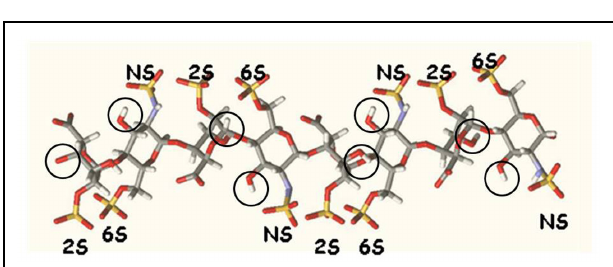
FIGURE 3 | Molecular model of an octasaccharide segment of heparin (Mulloy et al., 1993). The structure shows a regular distribution of sulfated groups on both sides of the molecule. Circles indicate the position of the hydroxyl in position